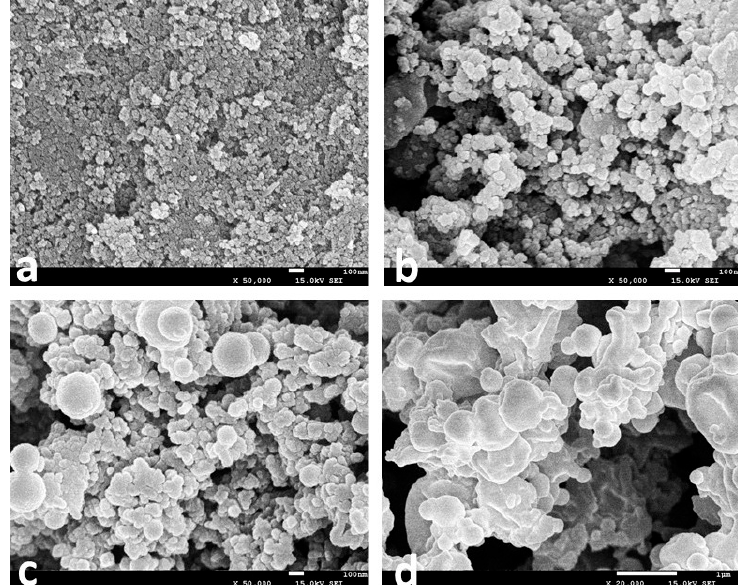
Figure 3. SEM images of ( a ) Fe 3 O 4 ; ( b ) APTES–Fe 3 O 4 ; ( c ) magnetic CALB CLEAs; ( d ) CALB CLEAs.